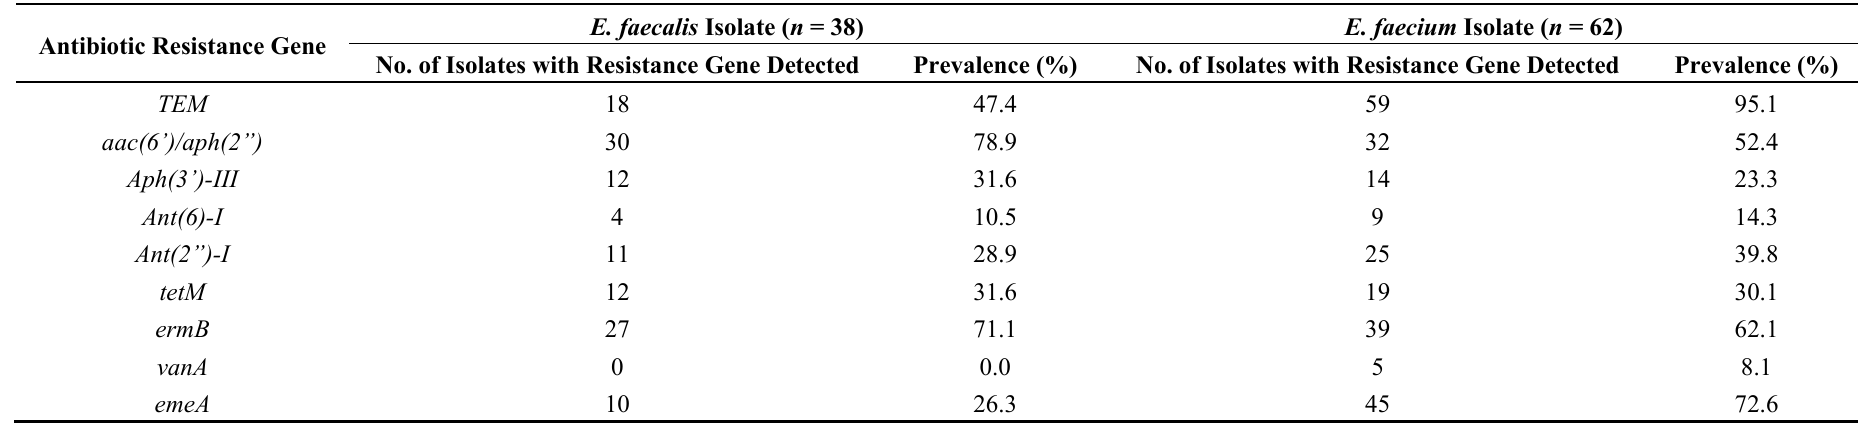
Table 9. Detection of antibiotic resistance genes in multiple-drug resistant E. faecalis and E. faecium . Antibiotic Resistance Gene